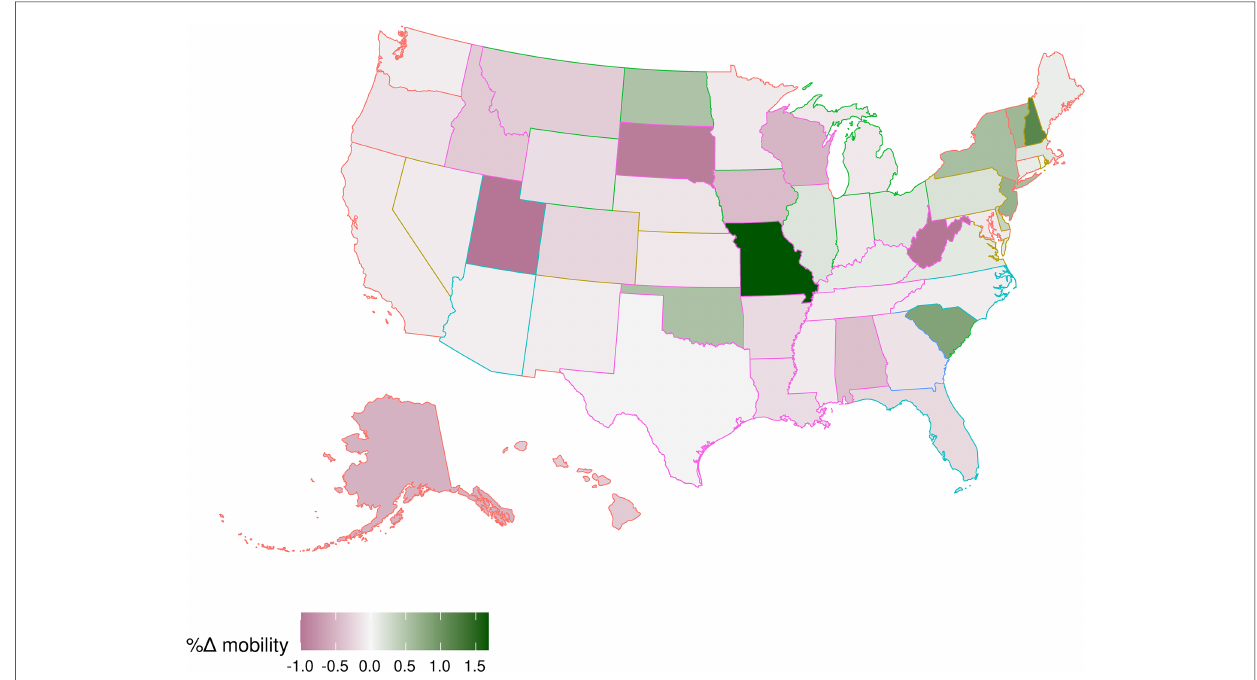
FIGURE 4 Percentage change in mobility near abortion clinics by state for Texas devices relative to non-Texas devices (outline colors correspond to Figure 1 ). Each state is shaded according to the predicted percentage change in mobility from Texas to the state following SB8 ’ s implementation. Estimates are from destination-state speci fi c two-way fi xed effects Poisson regressions of visitors on a dummy for a Texas origin interacted with Post SB8, including (destination) clinic-by-origin Census block group and date fi xed